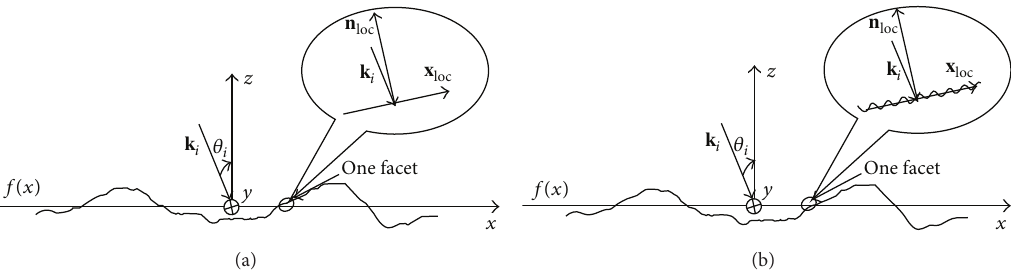
Figure 2: Configuration of sea surface; (a) sea profile constructed by large facet: simplified sea surface without capillary wave; (b) the simplified sea surface: capillary waves are